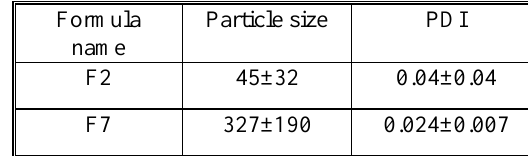
Table 3.The Particle Size and PDI of NMD NPs After Lyophilization.